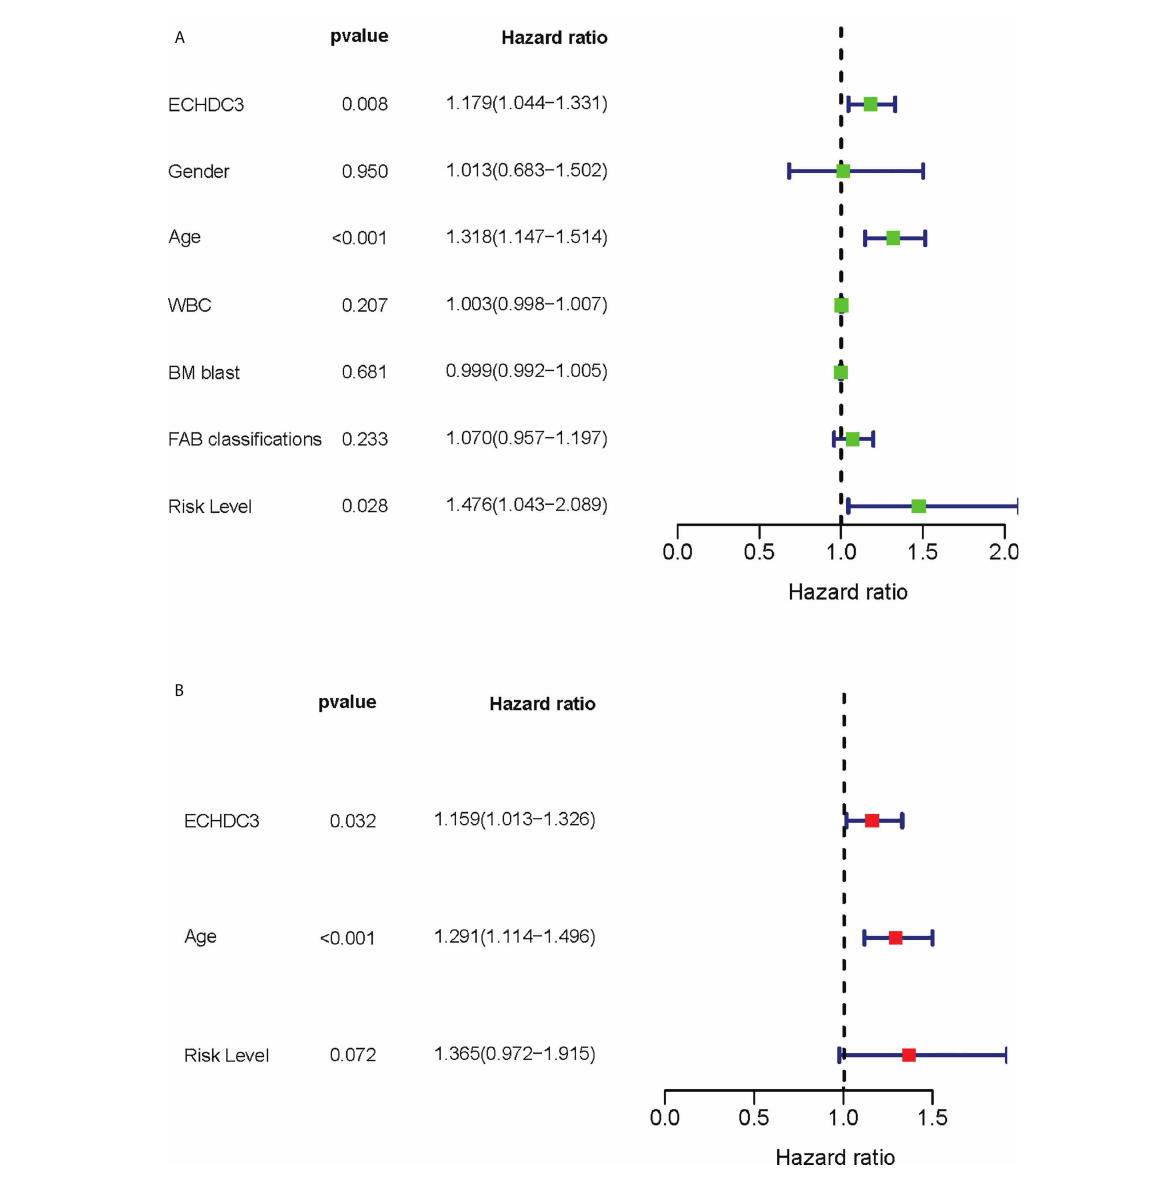
FIGURE 3 Cox regression analysis of ECHDC3 expression in validation sets. (A) Univariate Cox regression analysis for identi fi cation of AML patients ’ clinical character in validation sets. (B) Multivariate Cox regression analysis for identi fi cation of AML patients ’ clinical character in validation